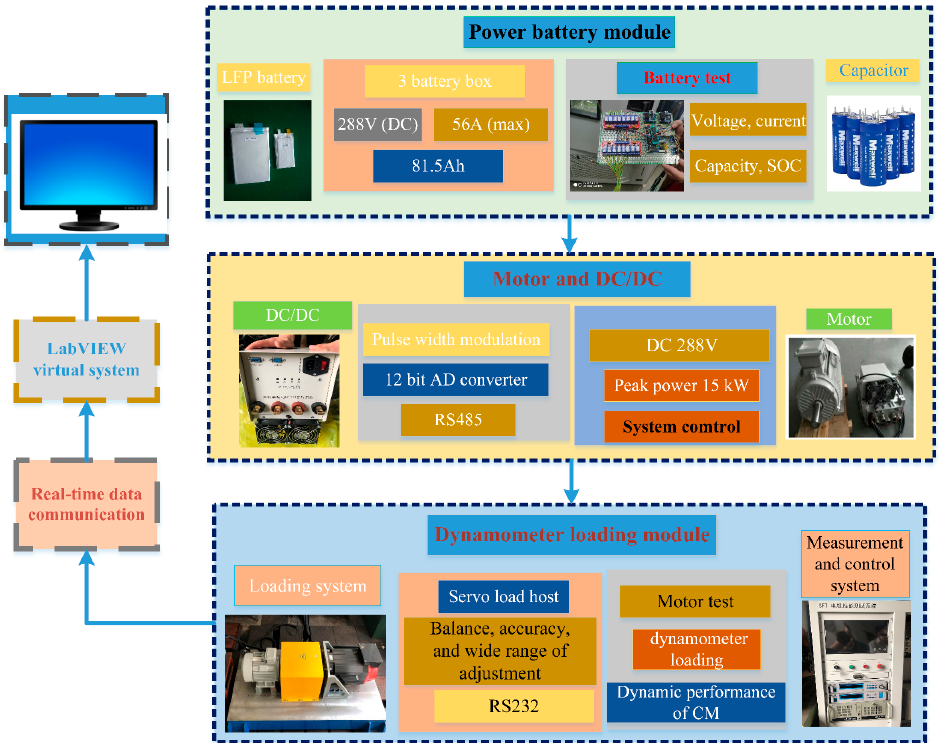
Figure 11. The experimental platform of electric construction machinery.